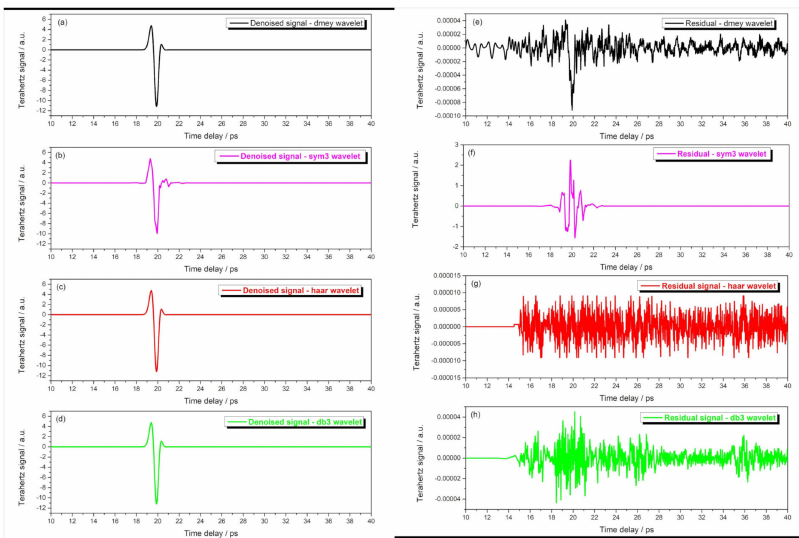
Figure 4. The denoised signals ( a – d ) and residual distributions ( e – h ) (taking the signal with thickness 0 µ m as an example): ( a ) dmey wavele; ( b ) sym3 wavelet; ( c ) haar wavelet; ( d ) sym3 wavelet; ( e ) dmey wavele; ( f ) sym3 wavelet; ( g ) haar wavelet; ( h ) sym3